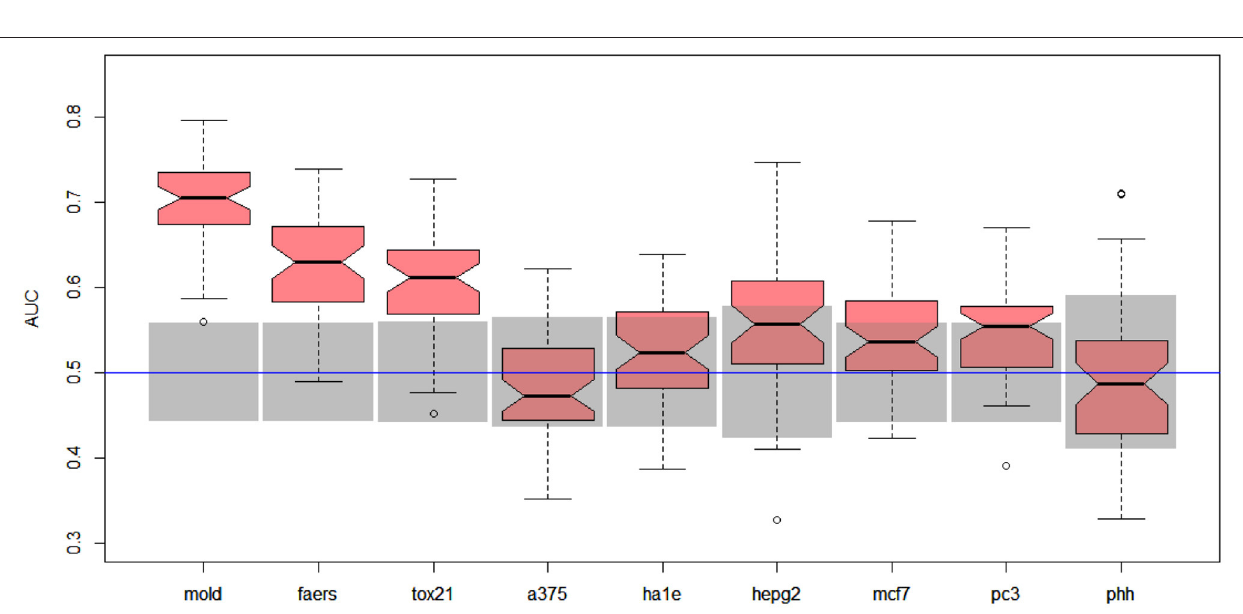
FIGURE 3 | Results for DILI3 decision (“withdrawn,” “box warning,” and “warning and precaution” vs. “adverse event” and “no match”) on various data sets. Gray boxes correspond to 95% confidence interval for the null hypothesis. Predictions based on MOLD, FAERS, and tox21 are significantly better than random ones. Results for HEPG2, MCF7, and PC3 are on border between random and non-random ones.